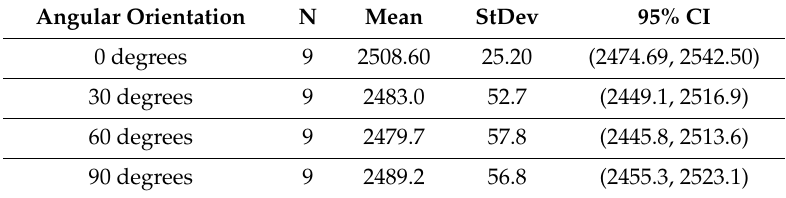
Table 10. Mean, standard deviations, and confidence interval of E as a function of angular